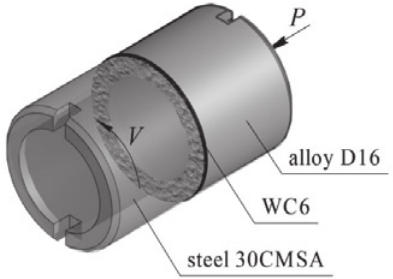
Fig. 5. The interaction scheme of friction unit samples: P indicates axial load; V – rotation speed During the experiments, the AE signals were re- corded under normal wear. The sampling interval of the input signal (analogue signal to digital code transform- ation) was equal to 10 microseconds. For further pro- cessing of the AE signals average amplitudes were used.